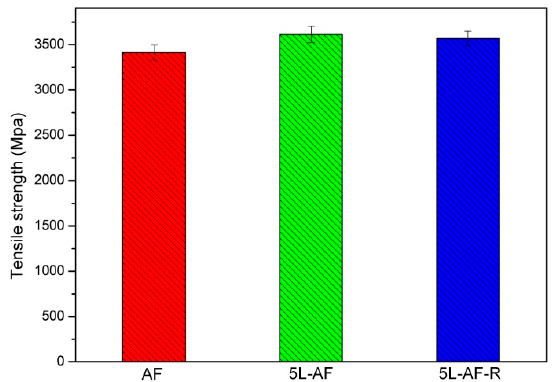
Figure 7. Tensile strength of single aramid fibers before and after treatment with layer-by-layer self-assembly of L -PDOPA and electrostatic adsorption acidification of silane coupling agents (KH550).